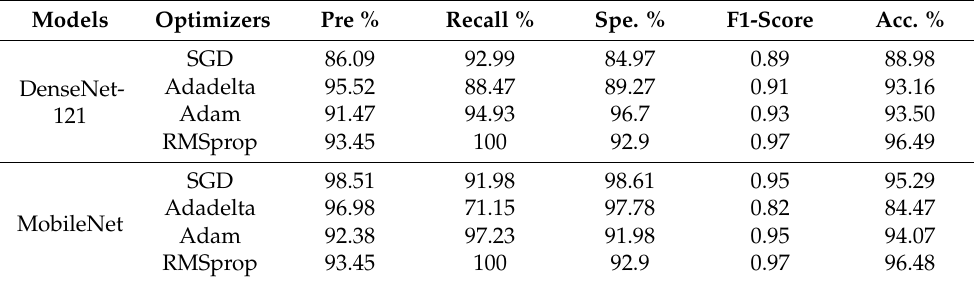
Table 7. Comparison of classification performance of DenseNet-121 and MobileNet among different